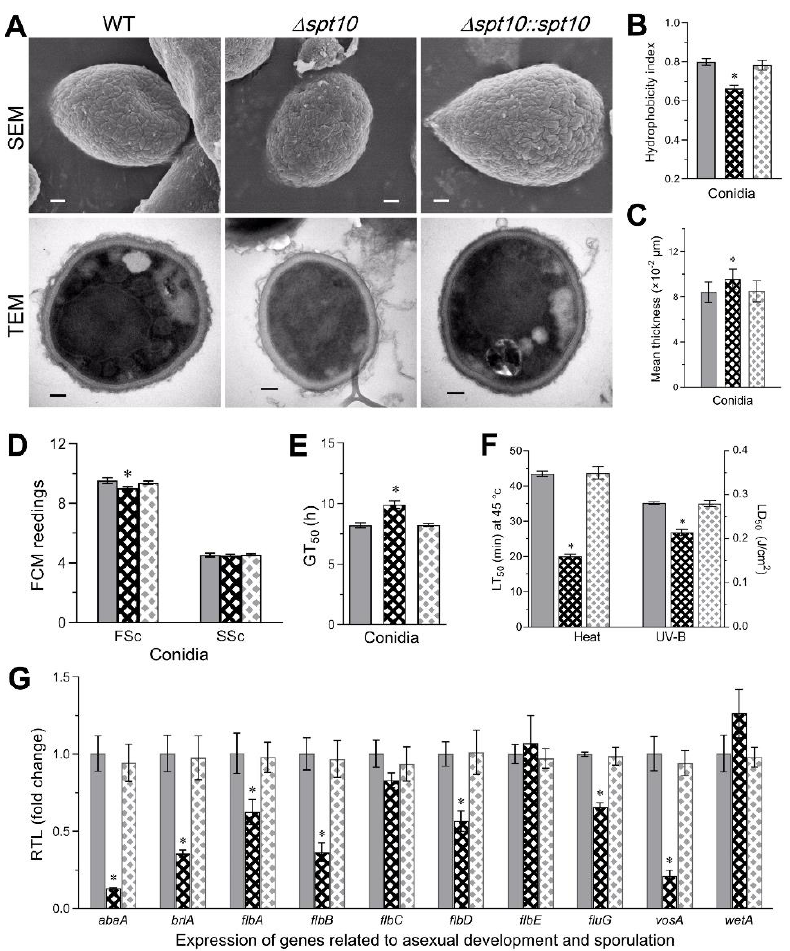
Figure 2. Impact of Spt10 deletion on conidiation capacity and conidial properties. ( A ) SEM and TEM images for the conidia harvested from the 7-day-old SDAY cultures (scale bars for upper and lower panels: 0.2 μm). ( B ) Conidial hydrophobicity index quantified in an aqueous-organic system. ( C ) The mean cell wall thickness of conidia harvested from the 7-day-old SDAY cultures. ( D ) FACS analysis for cell size (FSc) and density (SSc) of aerial conidia collected from 7-day-old SDA cultures. ( E , F ) Conidial viability indicated by GT 50 and conidial tolerance to heat stress and UV-B irradiation, respectively. ( G ) Relative transcript levels of 10 development-required genes in the 3-day-old SDAY cultures of Spt10 mutants with respect to the WT standard. Asterisked bar in each three-bar group differs significantly from those unmarked (Tukey's HSD, * indicates p < 0.05). Error bars: SD from three replicates.